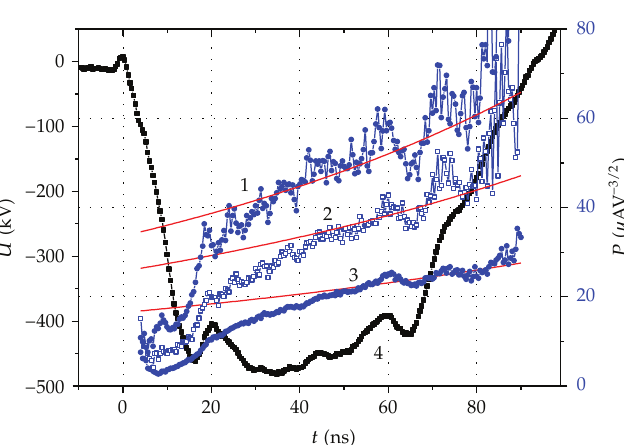
Figure 5: Experimental (cid:2) dots (cid:3) and calculated (cid:2) solid line (cid:3) values of the perveance of the planar diode with a graphite cathode with a diameter of 45mm and gap of (cid:2) 1 (cid:3) 11, (cid:2) 2 (cid:3) 12.5, and (cid:2) 3 (cid:3) 14mm. (cid:2) 4 (cid:3) represents a waveform of voltage.